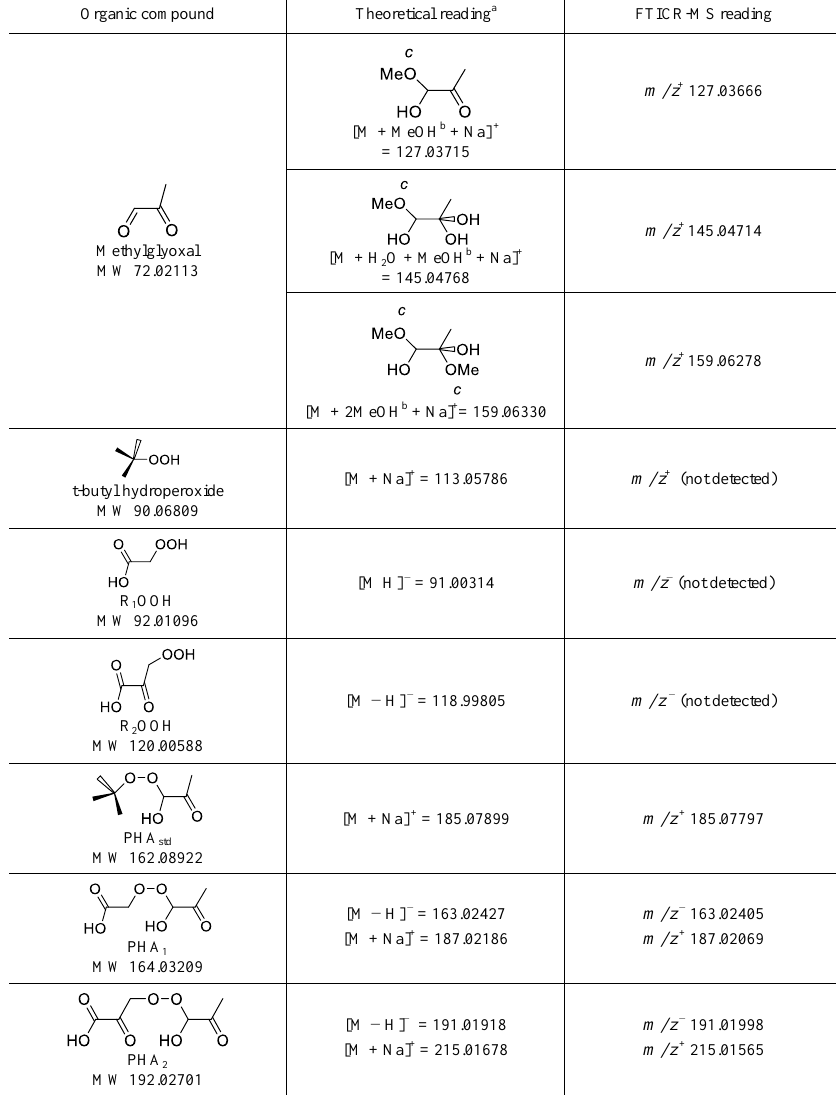
Table 1. FTICR-MS and theoretical readings for methylglyoxal, organic peroxides and peroxyhemiacetals. Organic